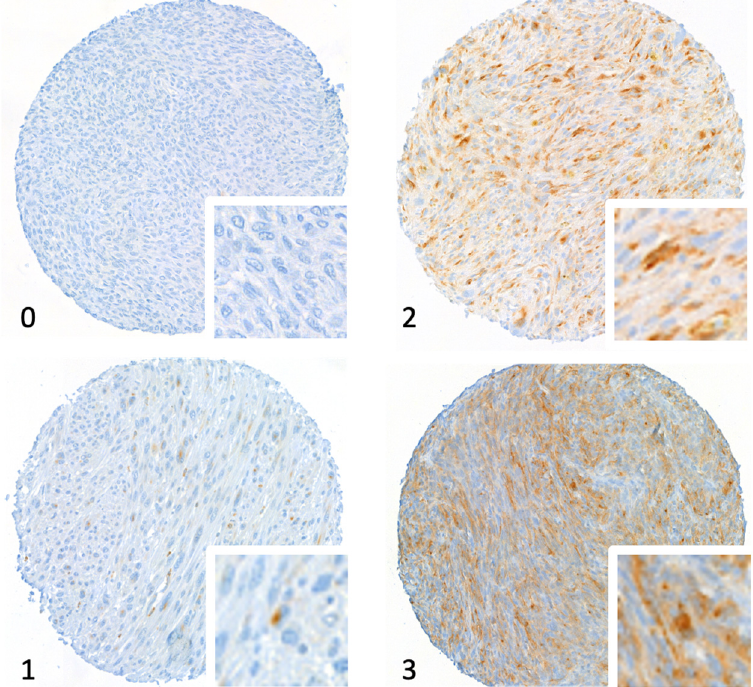
Figure 1. Tissue microarray stained for V domain immunoglobulin suppressor of T cell activation (VISTA). The figure shows core micrographs representative of semiquantitative immunostaining scores: 0, negative; 1, weak; 2, moderate; and 3, strongly positive. Magnification 20×. Table 2. V domain immunoglobulin suppressor of T cell activation (VISTA) expression and TILs for different histologic subtypes: The table shows the number and percentage of patients with different VISTA expression scores (0 to 3) and positive expression (score 1 to 3) and high tumour-infiltrating lymphocyte (TIL) infiltration ( ≥ 6 TILs per HPF). UPS: undifferentiated pleomorphic sarcoma; DDLPS: dedifferentiated liposarcoma; MPNST: malignant peripheral nerve sheath tumour.